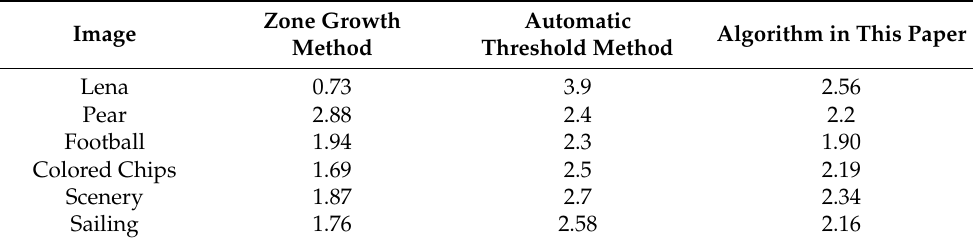
Table 1. Comparison of average segmentation time of the algorithm